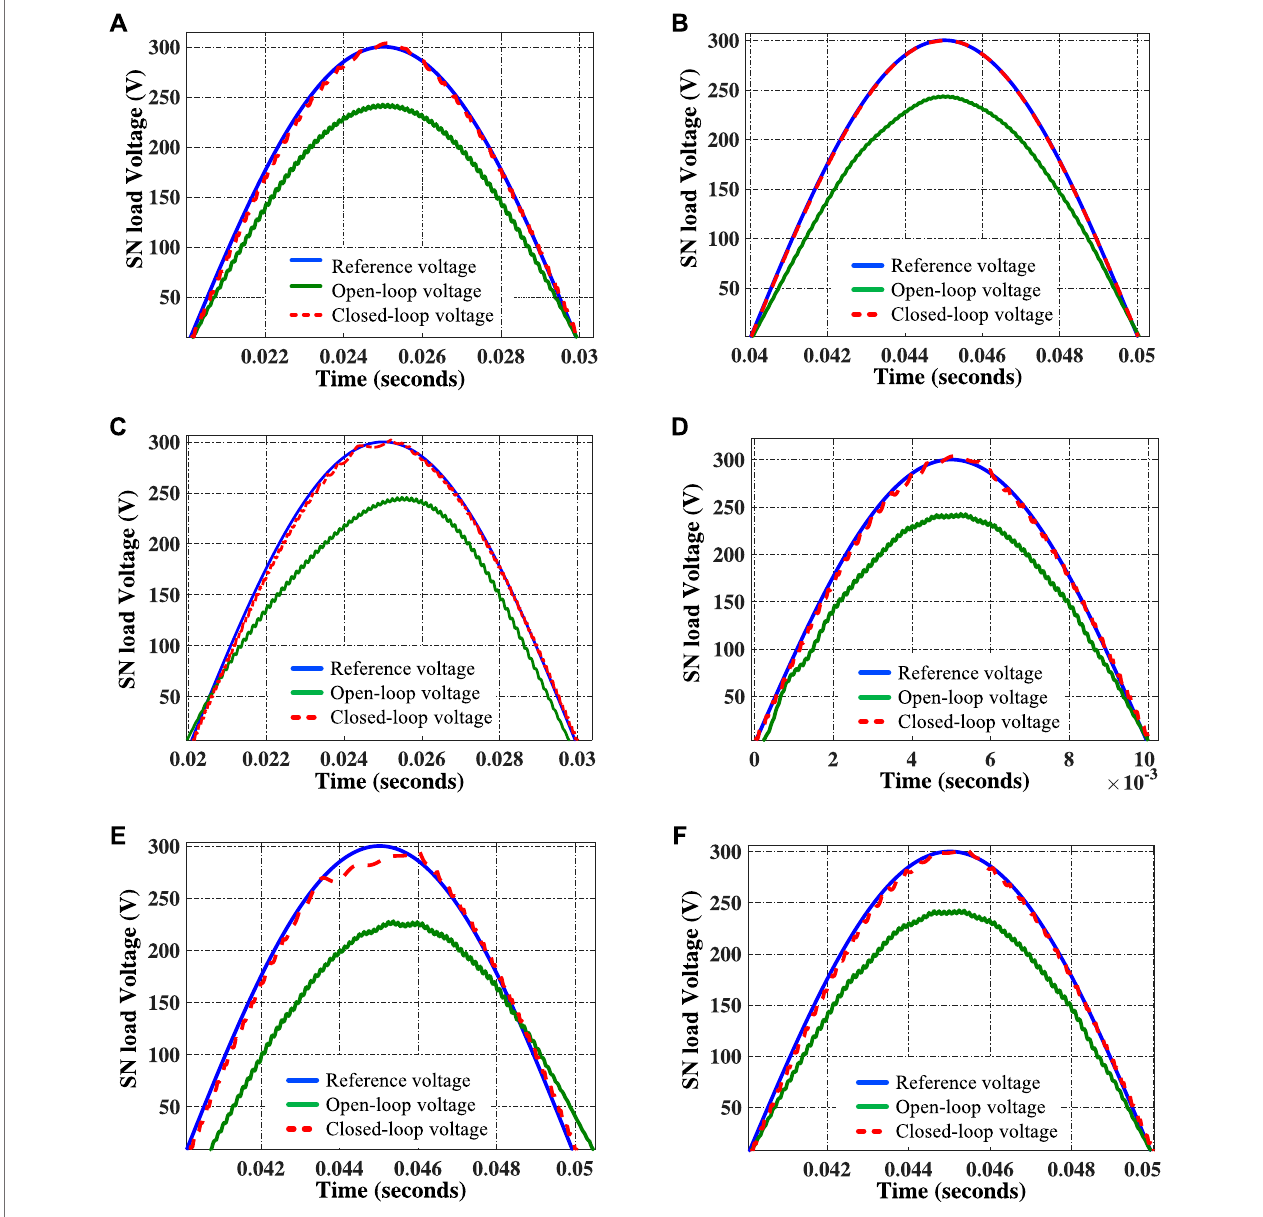
FIGURE 9 | Comparison of open-loop, closed-loop and reference SN voltage tracking under (A) Consumer load; (B) Unknown load; and (C) Harmonic load; (D) Nonlinear load; (E) Asynchronous machine load; and (F) Dynamic load.